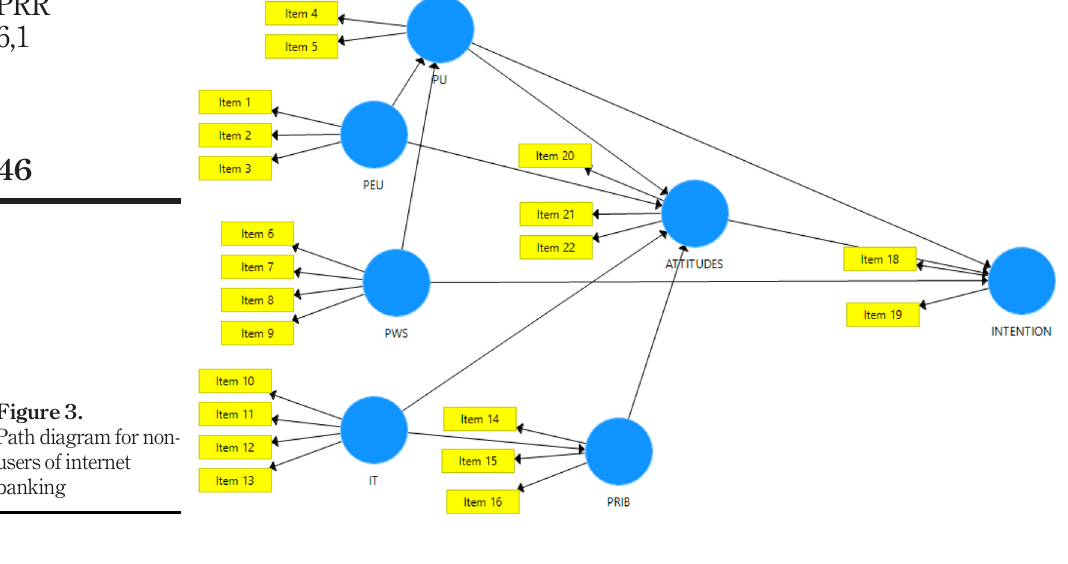
Figure 3. Path diagram for non- users of internet